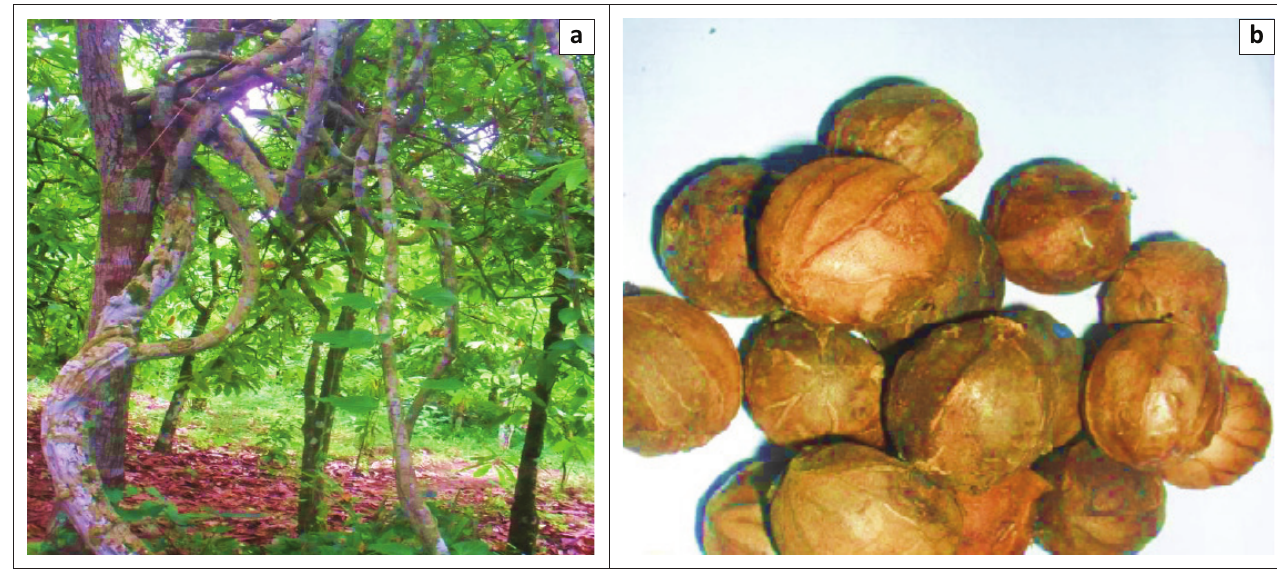
FIGURE 1: Tetracarpidium conophorum in its natural habitat (a) and seed nuts